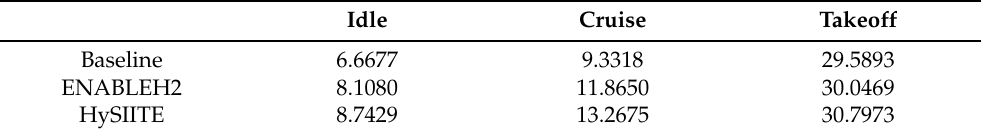
Table 2. Simulation results of core pressure ratio of three configurations under different operating points. Idle Cruise Takeoff Baseline 6.6677 9.3318 29.5893